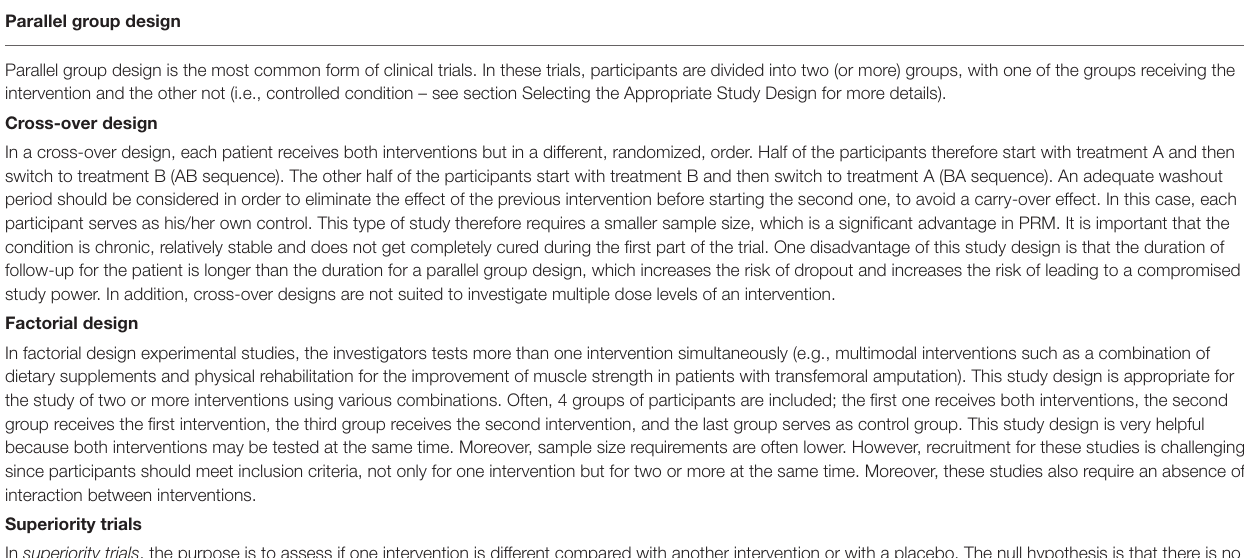
TABLE 2 | Different interventional study